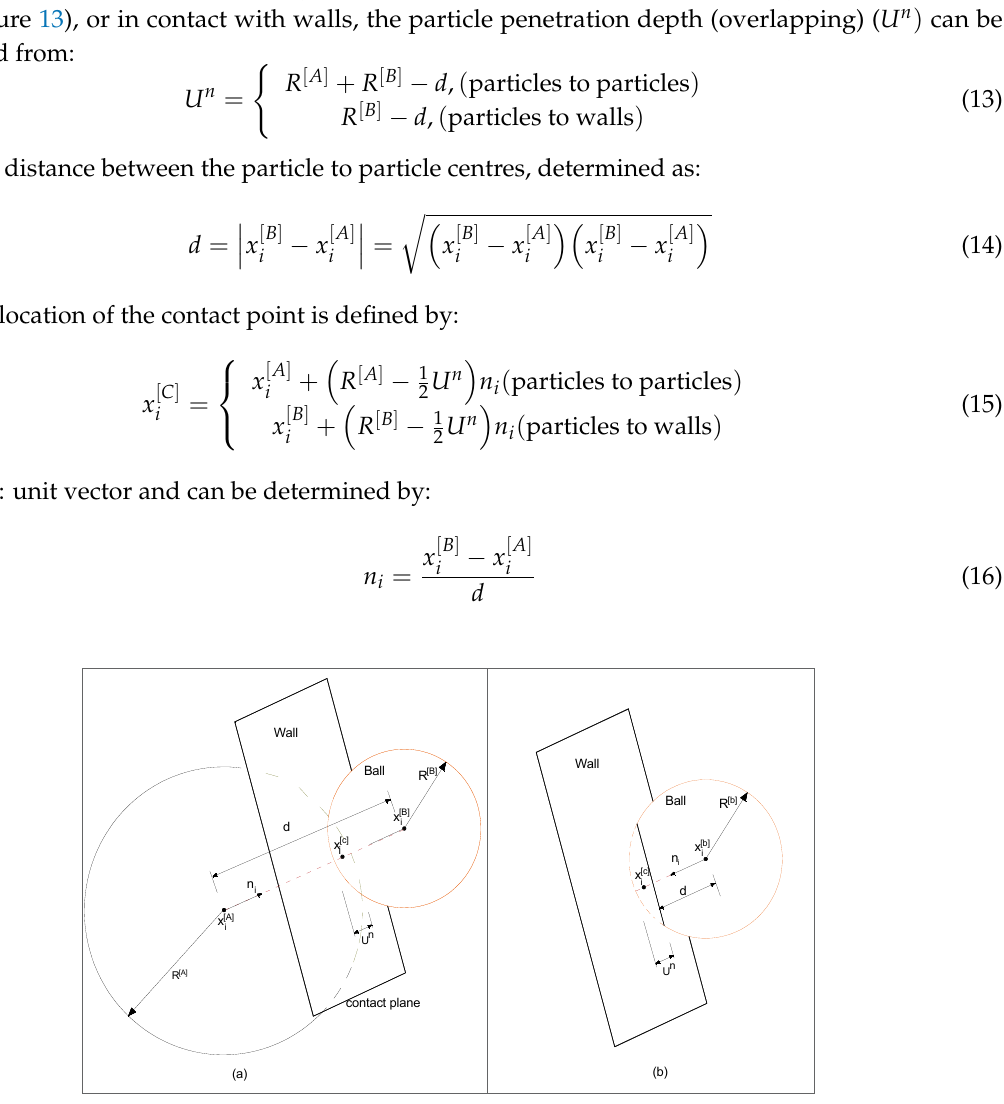
Figure 13. Notation used to describe contacts in DEM: ( a ) ball-ball contact; ( b ) ball-wall contact → F that represents the interaction between the two particles At a given time, the force vector